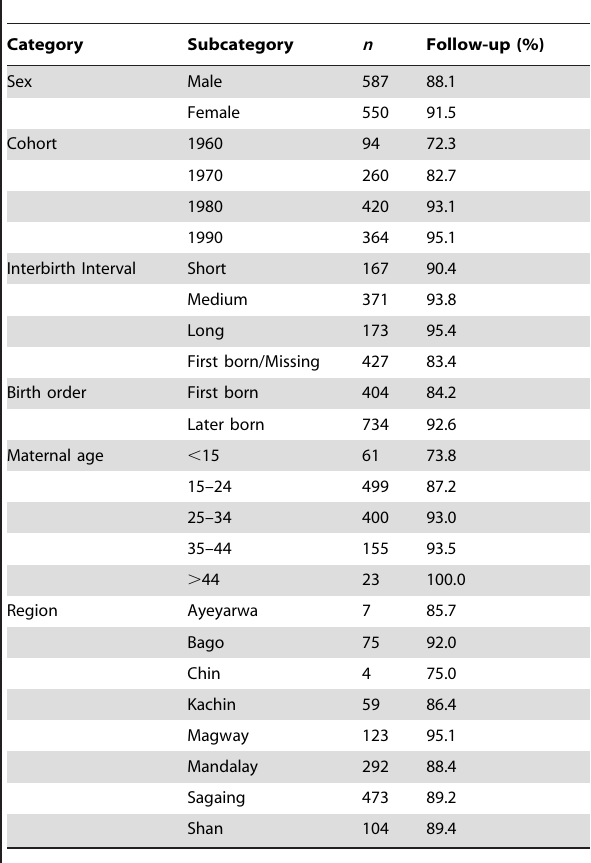
Table 1. Descriptive statistics of the data used in the analyses (stillbirth and liveborn survival models) of Asian elephants illustrating the sample size and data